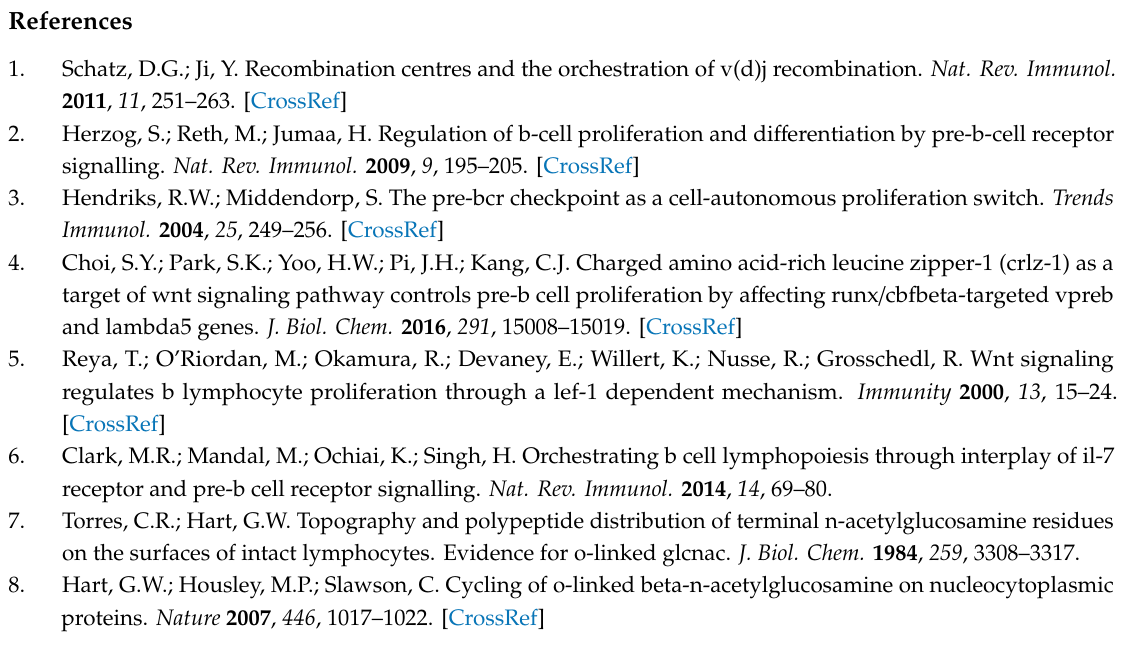
Figure S1: Pro-B cells and large pre-B cells were sequentially sorted by MACS using B220 microbeads and then by FACS using CD43 and IgM or pre-BCR as markers, Figure S2: Pre-B cell proliferation is significantly decreased by inhibition of O-GlcNAcylation without any significant cell death, Figure S3: THP-1 cell growth is una ff ected by treatments of O-GlcNAc related inhibitors, Figure S4: Unchanged expression of factors regulating pre-B cell proliferation following inhibitor treatment, Table S1: Primers used in this